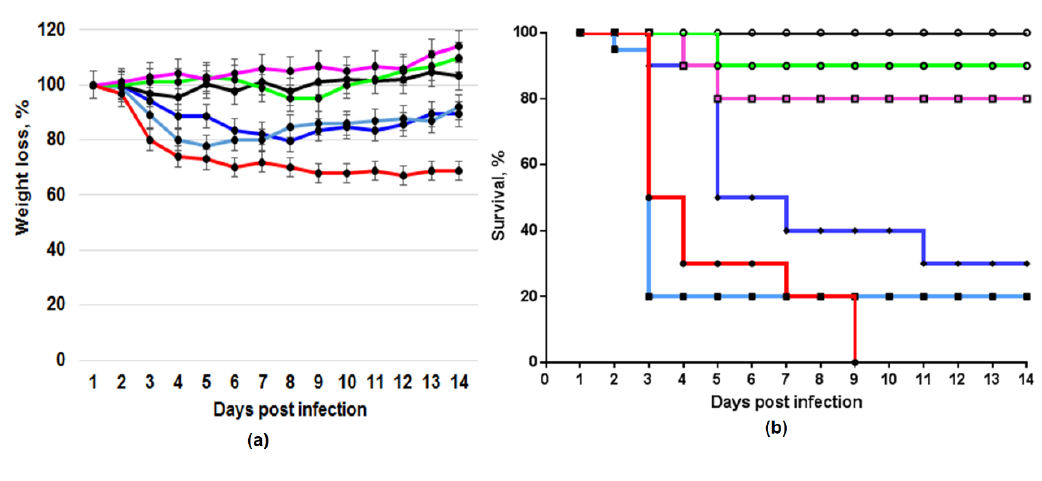
Figure 1. Weight loss and lethality of the influenza viruses for BALB/c mice. Weight loss, %, p < 0.05 ( a , c , e ), and survival, % ( b , d , f ), were monitored daily for 14 days. Mice were inoculated intranasally with 8.5 log 10 EID 50 ( a , b ), 7.5 log 10 EID 50 ( c , d ) or 5.0 log 10 EID 50 (1–10 LD 50 ) ( e , f ). The pathological examination of the lungs of dead mice showed that acute pulmonary edema affected all lobes of the lung. At the time of toxic death, the lungs were hemorrhagic (Figure 2a).